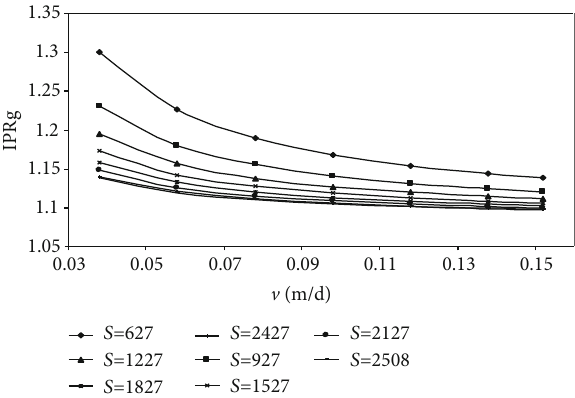
Figure 2: The relationship between the gas IPR and the velocity of the combustion front under di ff erent cross-section areas of